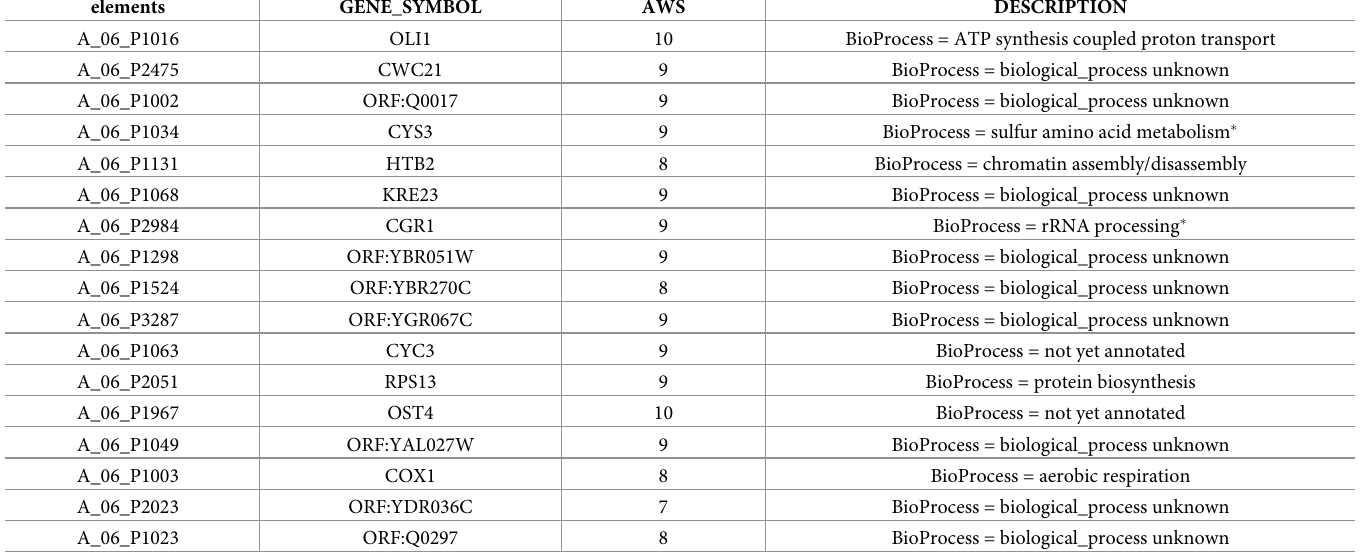
Table 2. Decision tree models roots identified as exhibited 100%